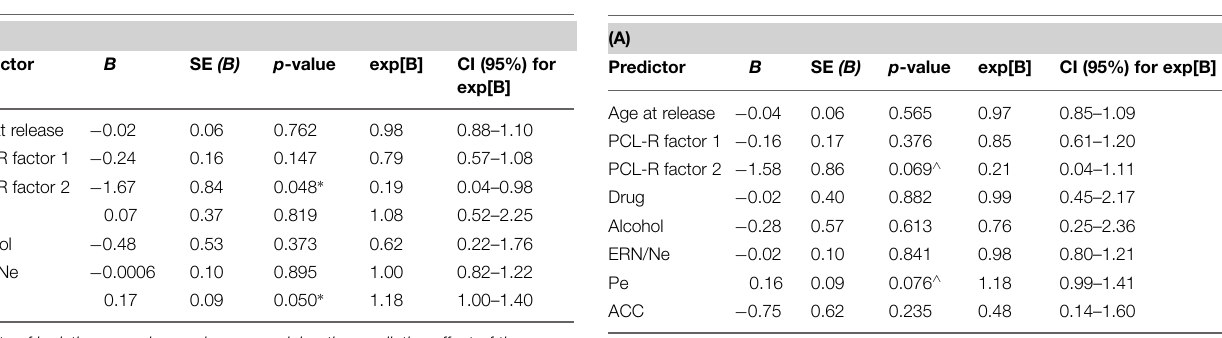
TABLE 7 | Logistic regressions combining ERP, fMRI, and covariates predicting rearrest ( N =